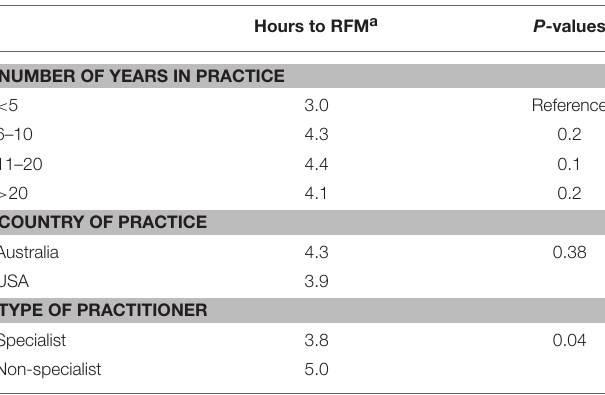
TABLE 1 | Univariate analyses of factors influencing the number of hours after parturition until fetal membranes are considered retained by practitioners. Hours to RFM a P